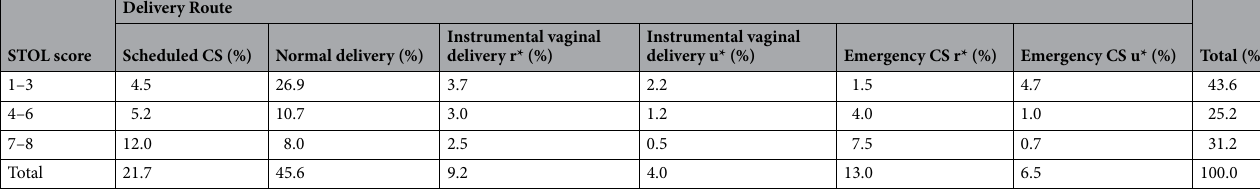
Table 2. STOL score compared with real delivery route. A Kruskal–Wallis H test showed that there was a statistically significant difference in delivery route between the different STOL categories, H = 6.136, p = 0.047. CS cesarean section, r* related to cephalopelvic disproportion, u* unrelated to cephalopelvic disproportion, STOL simulated trial of